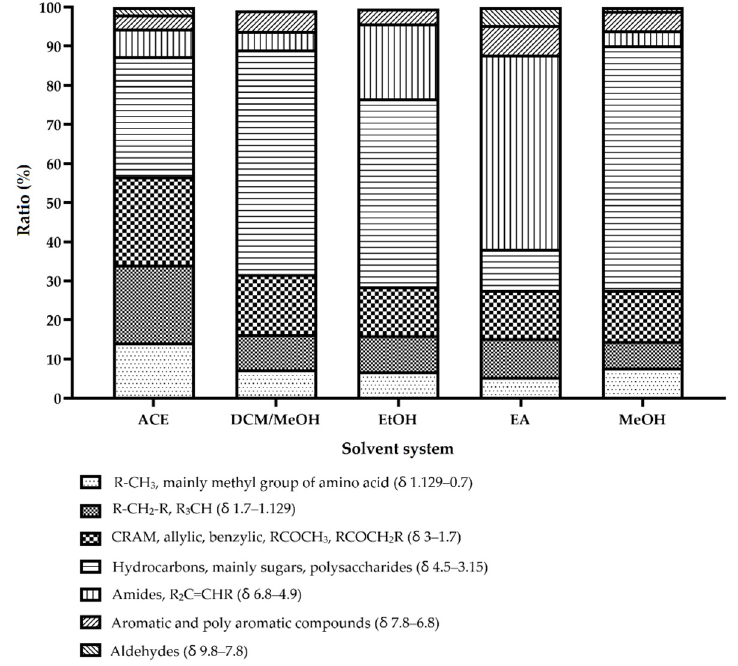
Figure 1. Functional group ratio comparison of different solvent extractions of E. foeminea . MeOH, methanolic extract; DCM/MeOH, dichloromethane/methanol extract; Ace, acetone extract; EA, ethyl; EtOH, ethanolic extract.